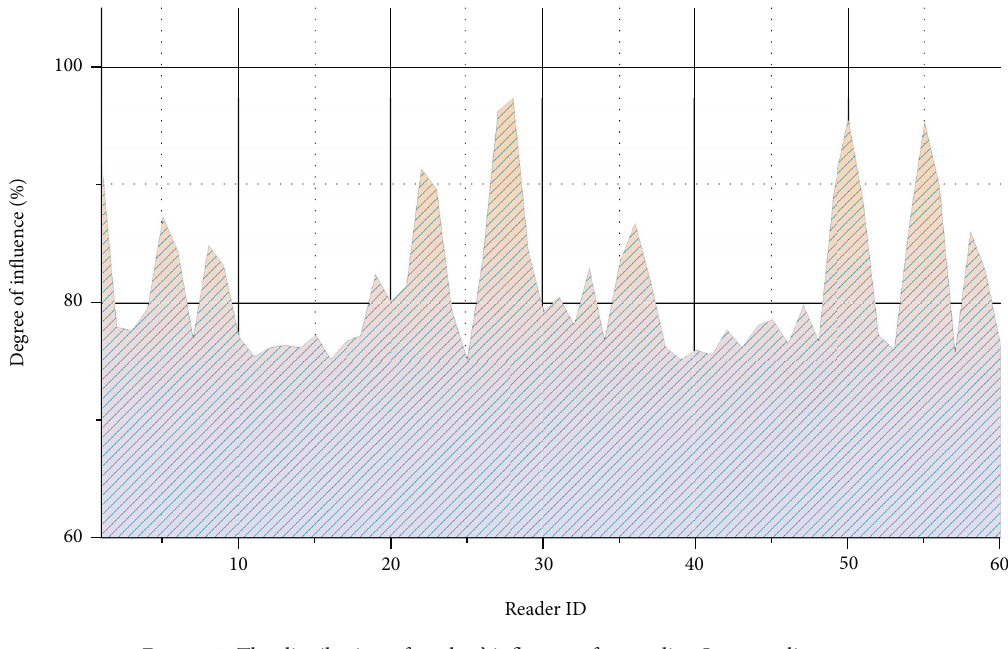
Figure 5: The distribution of readers ’ in fl uence after reading Japanese literature.